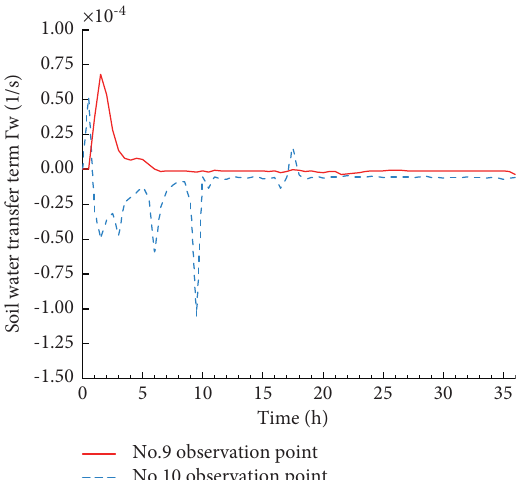
No.9 observation point No.10 observation Figure 14: Water transfer term versus time at Nos. 9 and 10 observation